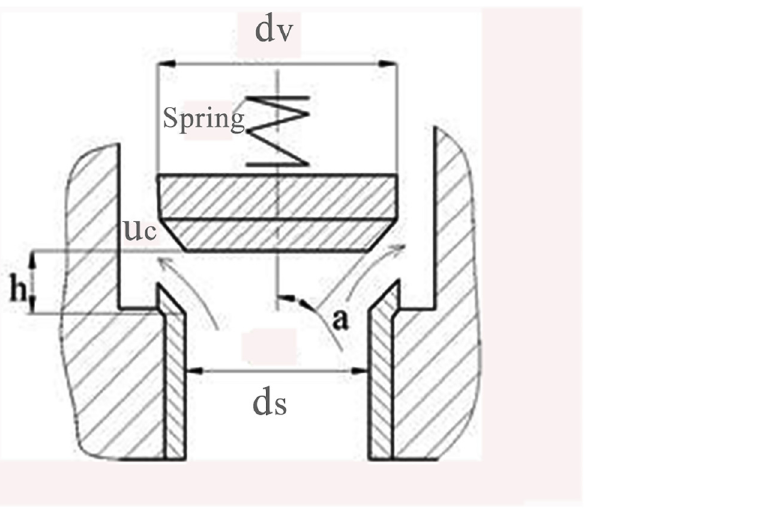
Fig 2. Schematic diagram of discharge side of a pump